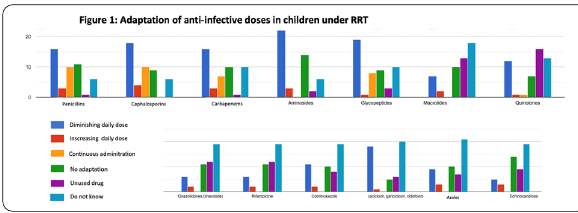
Figure 1: Adaptation of anti-infective doses in children under RRT CO‑13 High‑flow nasal oxygen alone or alternating with noninvasive ventilation in critically ill immunocompromised patients with acute respiratory failure. A randomised controlled trial COUDROY Rémi 1 , FRAT Jean-Pierre 1 , EHRMANN Stephan 2 , PÈNE Frédéric 3